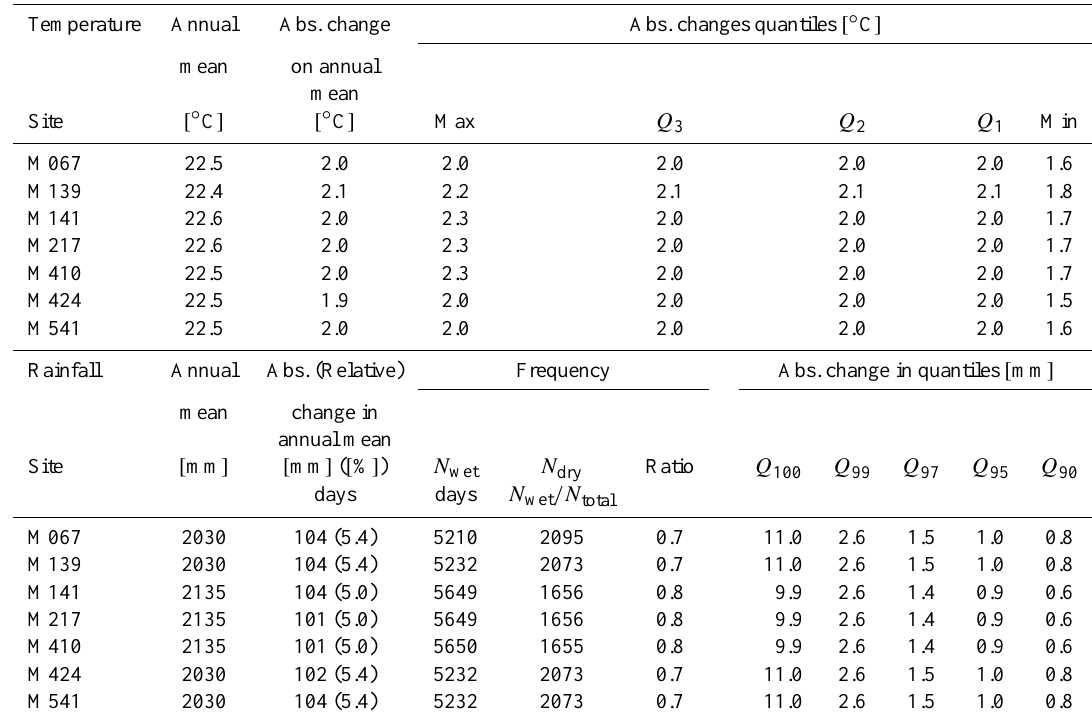
Table 3. Impact indicators for temperature and rainfall output series of GCM-RCMs without downscaling for 2045–2065, scenario A2.